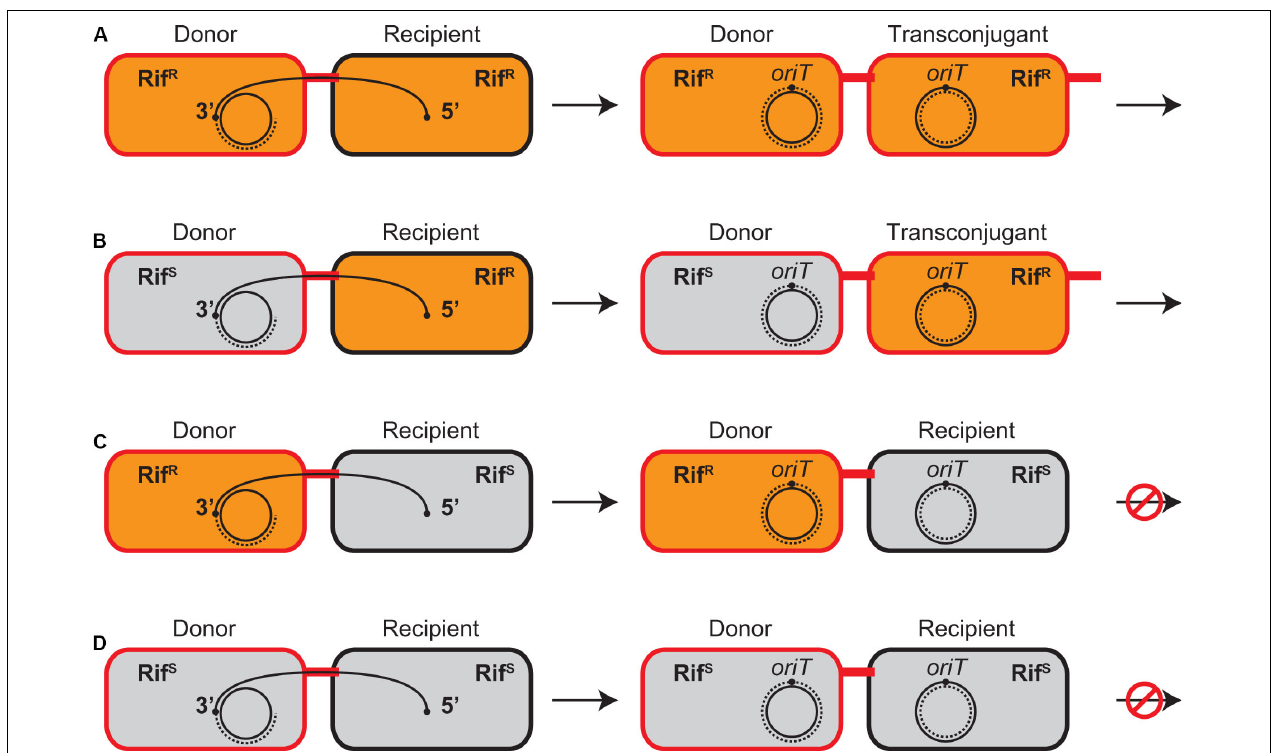
FIGURE 1 | Conjugative transfer between combinations of Rif R and Rif S strains in the presence of Rif. Rif R and Rif S cells are shown as orange and gray bacilli, respectively. The donor and transconjugant cells proficient in plasmid transfer are indicated in red while the recipient cells are indicated in black. The transfer strand is represented as a solid curve and its oriT sites are indicated by black dots, which is transferred from the donor to the recipient in a direction from 5 (cid:48) to 3 (cid:48) . The replacement and complementary strands are represented as broken lines. (A) Both donor and recipient are Rif R . (B) When recipient is Rif R , Rif does not prevent plasmid transfer from Rif S donor and new transconjugant is established. (C) When recipient is Rif S , Rif prevents establishment of transconjugant but not transcription in Rif R donor. (D) Both donor and recipient are Rif S . No transcription is initiated in the presence of